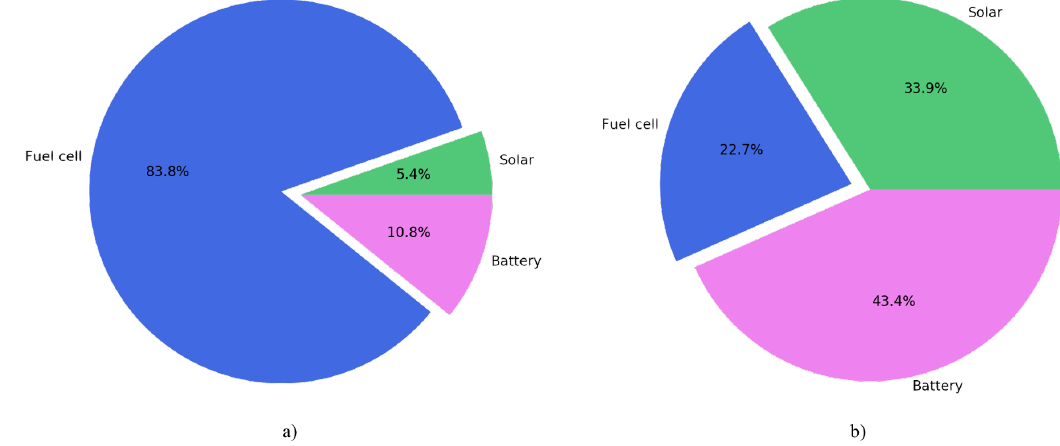
Figure 6. Example of energy usage by power sources for average consumer with priority-based internal agent ( a ) without fuel cell scheduling function and ( b ) with added scheduling